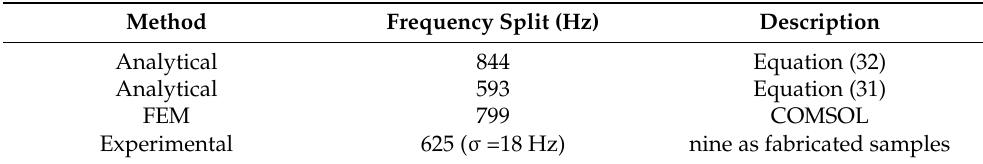
Table 3. Frequency split considering anisotropic Young’s modulus.